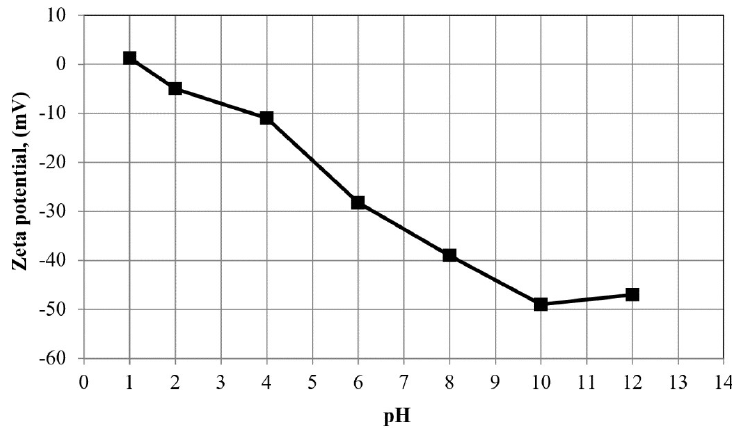
Figure 6. Oil droplet size distribution of artificially produced oil-in-water emulsion.